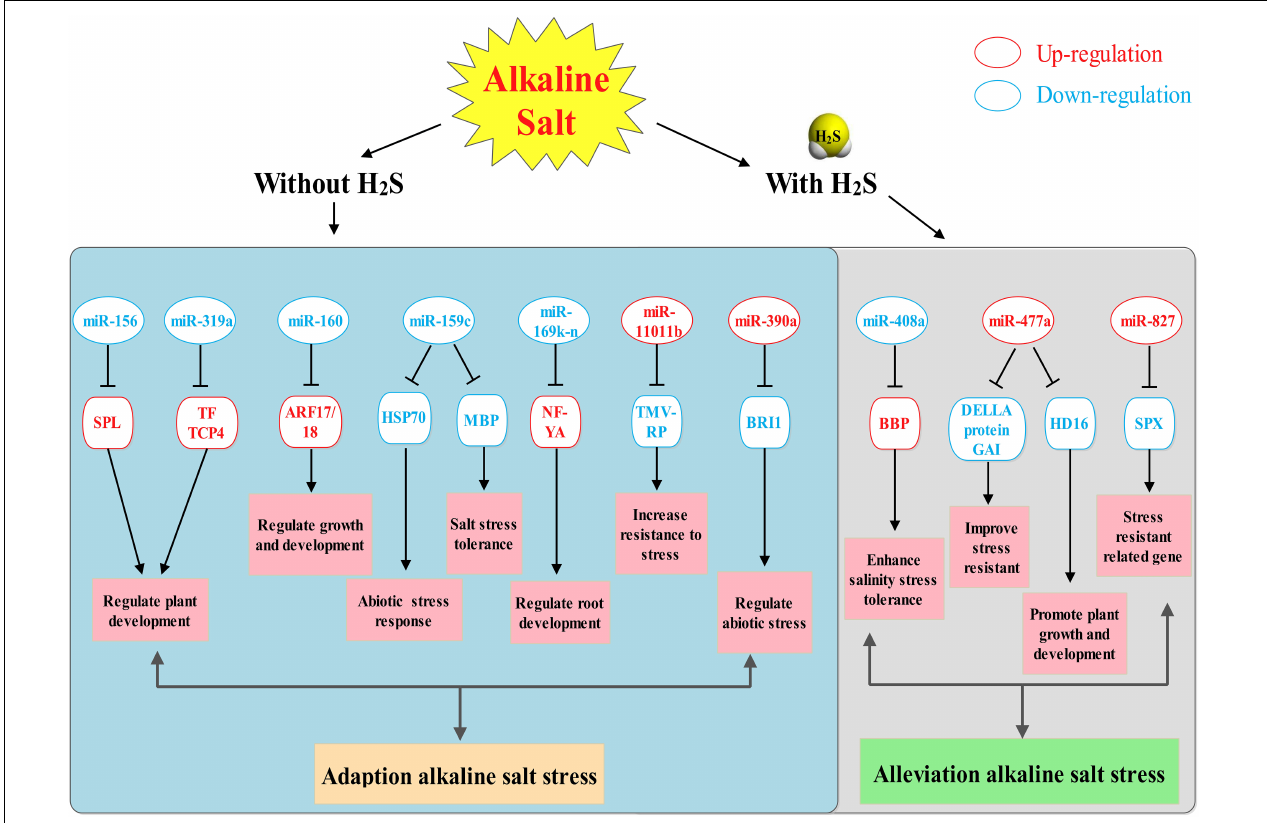
FIGURE 9 | A potential regulatory network model of miRNAs in H 2 S alleviates alkaline salt stress in M. hupehensis roots. This model reveals how H 2 S alleviates the alkaline salt stress through mediating miRNAs. ARF17, auxin response factor 17; BBP, basic blue protein-like; BRI1, receptor-like protein kinase BRI1-like 3; HSP70, heat shock 70 kDa protein; NF-YA, nuclear transcription factor Y subunit A-5-like; SPL, squamosa promoter-binding-like protein 18; SPX, SPX domain-containing membrane protein; TMV-RP, TMV resistance protein